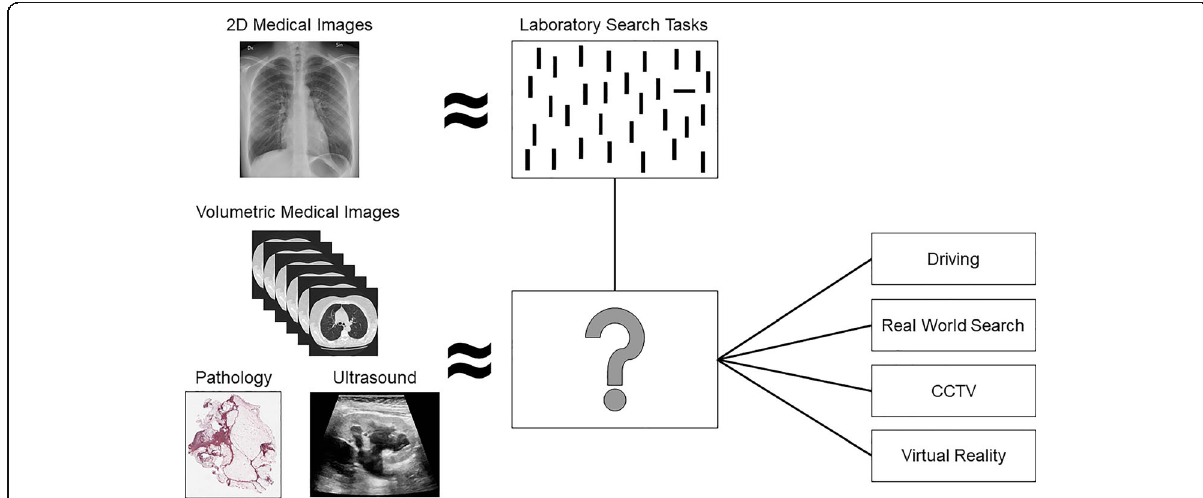
Fig. 2 Although many findings from laboratory visual search tasks have been replicated in the medical image perception literature (e.g., Evans, Georgian-Smith, et al., 2013; Drew et al., 2013), there is no clear analog to volumetric images in the basic science literature. However, insight for future research directions on volumetric image search might be gained from findings on 2D visual search, as well as growing research in the realms of driving, real-world visual search, closed-circuit television (CCTV), and virtual reality. Ultrasound image reprinted from Hansen et al. (2016). Ultrasonography of the kidney: a pictorial review. Diagnostics , 6 (1), 2., and used here under the Creative Commons License. Pathology image obtained from National Cancer Institute Clinical Proteomic Tumor Analysis Consortium Sarcomas (CPTAC-SAR) collection 2018 and used